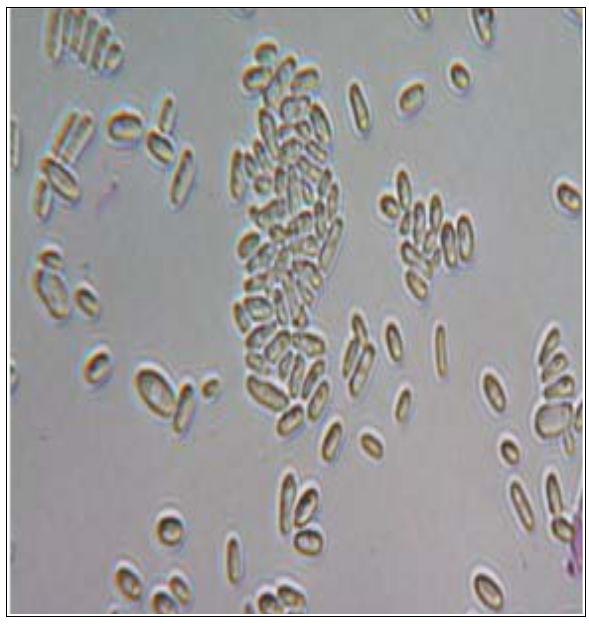
Figure 1 : Naturally occurring figure 1: Naturally occurring yeast isolated from marula fruit waste by-